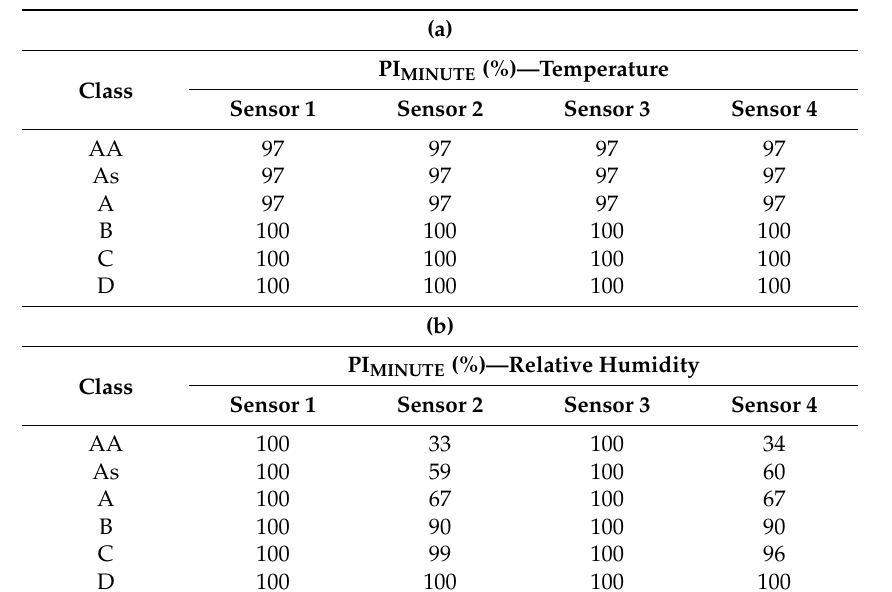
Table 9. Performance Index (PI MINUTE ) of T ( a ) and RH ( b ) values that fit individually into the specifications of each ASHRAE climate class in the case of one-minute sampling.